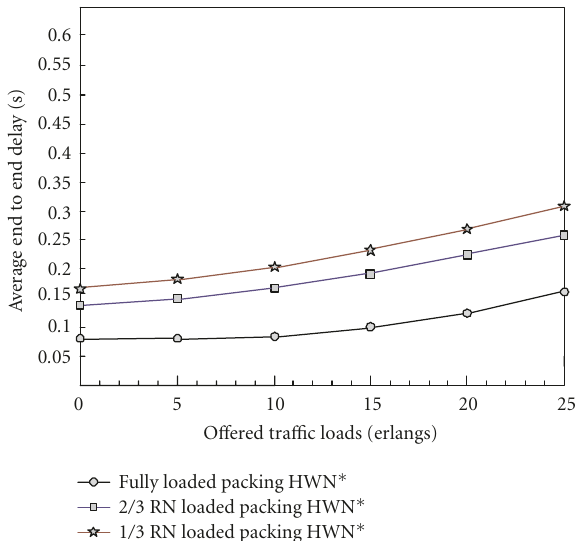
Figure 13: Average end-to-end transmission under various RN loads.